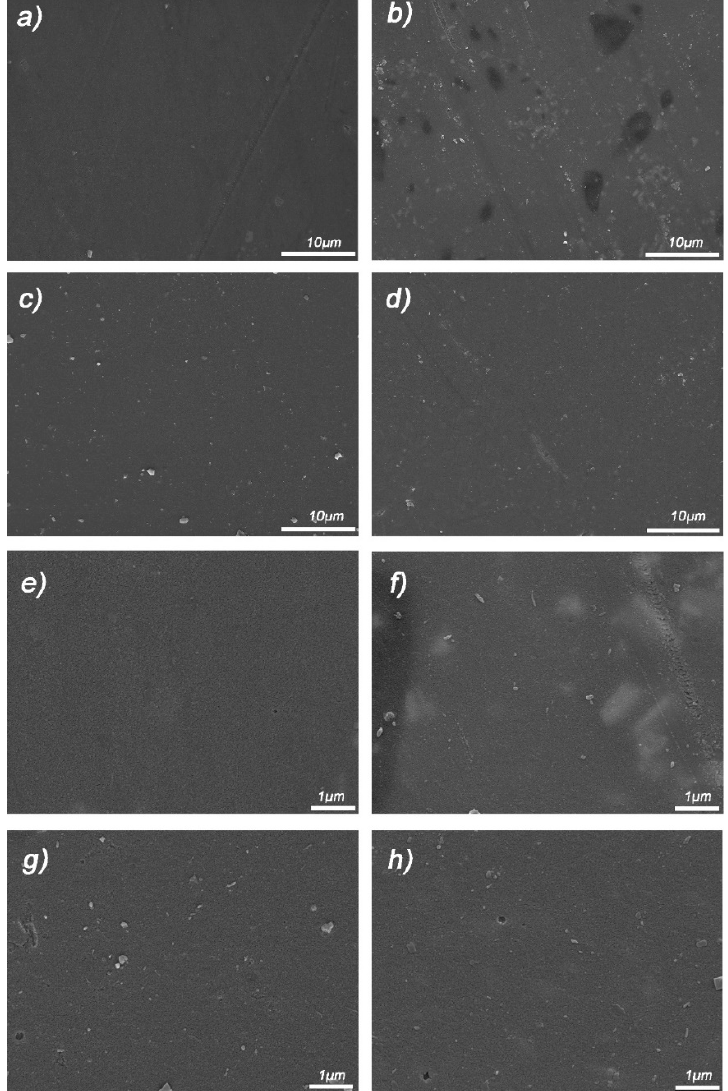
Figure 3. Field emission scanning electron microscopy (FESEM) images of the TiO 2 -coated glazed surfaces. Surface of: ( a ) tile 1BWT, ( b ) tile 2WT, ( c ) tile 3TST and ( d ) tile 4MWT. Higher magnification images of TiO 2 coating on: ( e ) 1BWT, ( f ) 2WT, ( g ) 3TST, and ( h ) 4MWT.